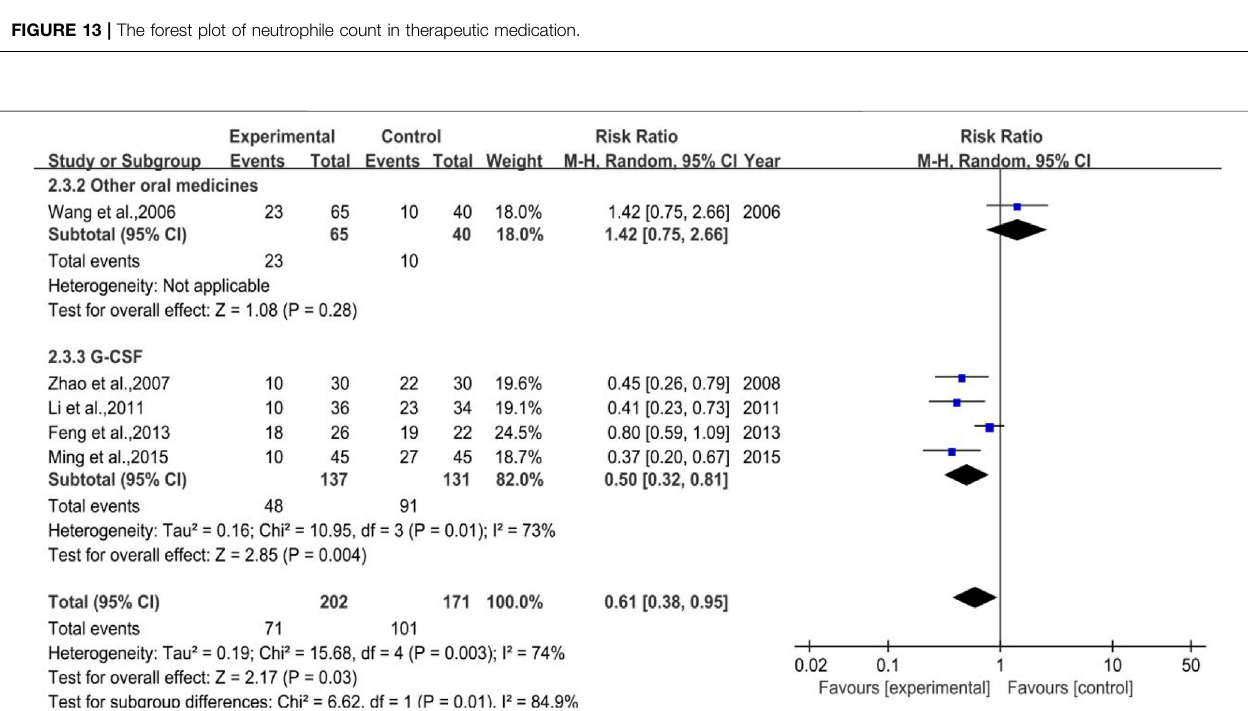
Frontiers in Pharmacology |